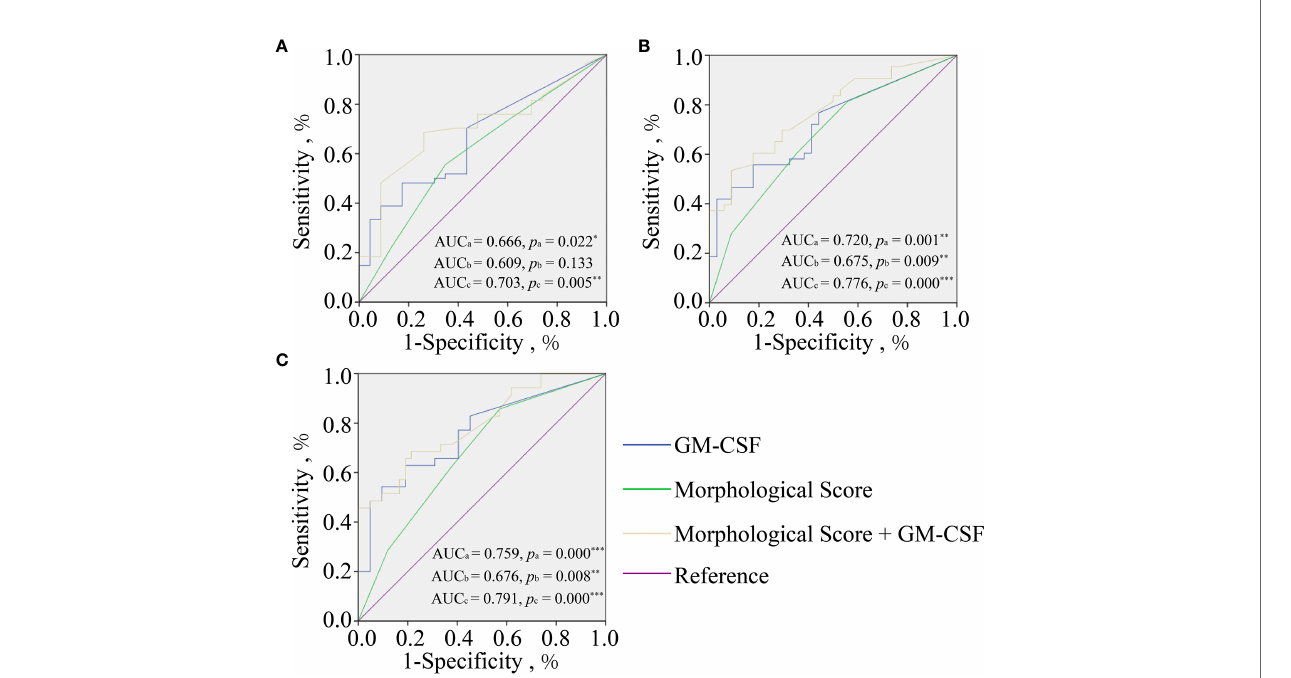
FIGURE 1 | Receiver operating characteristic curve analyses of GM-CSF alone (Blue line), morphological score (MS) alone (green line), and morphological score combined with GM-CSF (yellow line) for predicting pregnancy outcomes at different gestation periods including HCG positive (A) ; clinical pregnancy (B) ; ongoing pregnancy (C) . AUC a and P a for GM-CSF, AUC b and P b for MS, and AUC c and P c for combined indicator. * p < 0.05; ** p < 0.010; *** p <